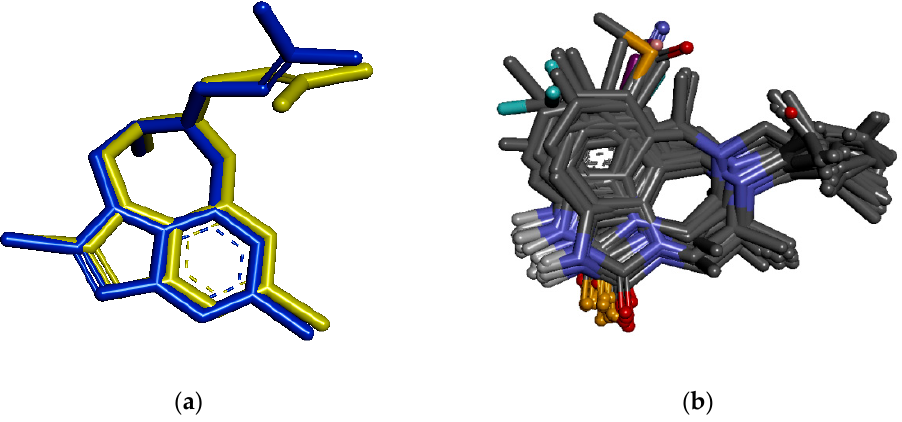
Figure 4. ( a ): Alignment view of the pre-existing (blue) and docked (yellow) ligands. ( b ): Alignment view of high and low TIBO derivatives.